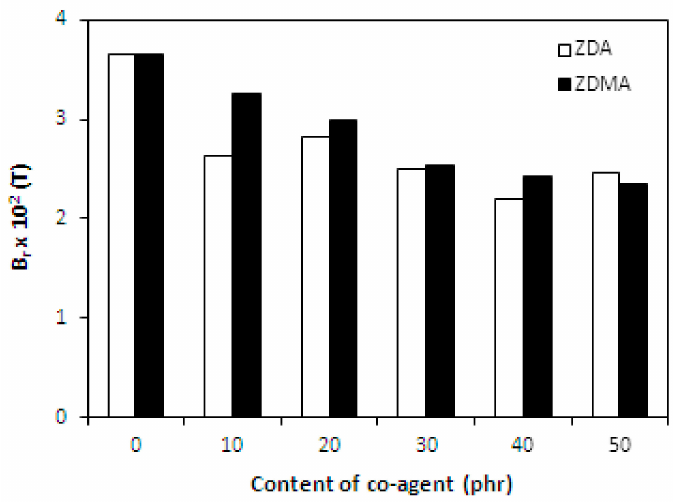
Figure 11. Influence of co-agents content on remanent magnetic induction B r of